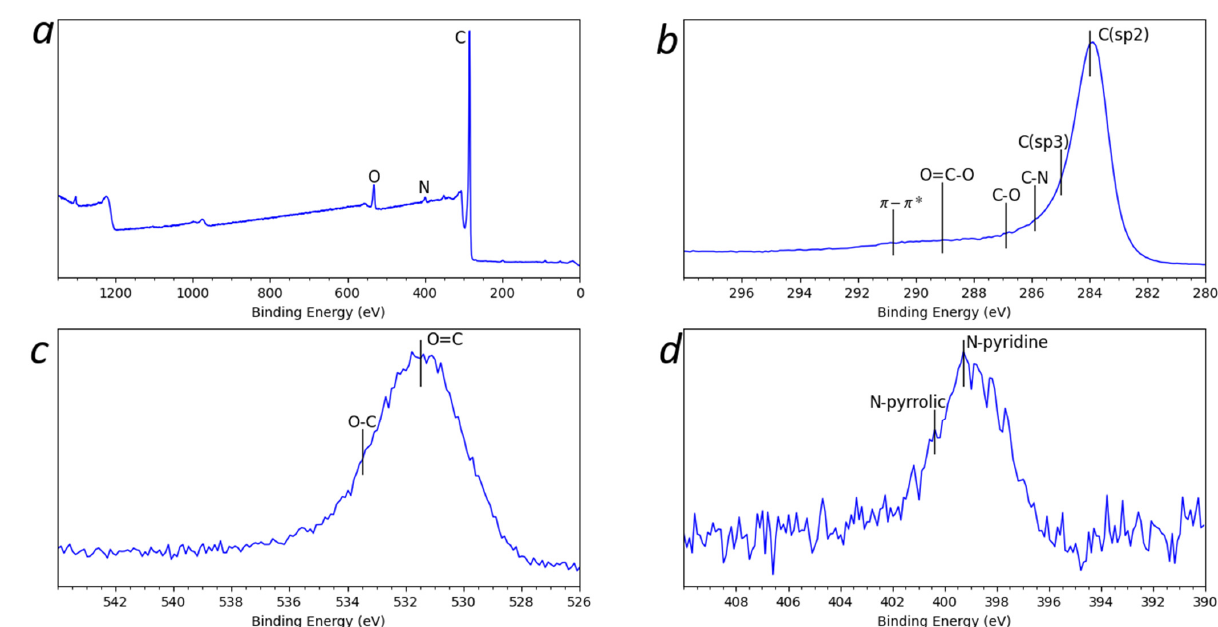
Figure 5. ( a ) XPS spectra analysis of ( b ) C1s, ( c ) O1s and ( d ) N1s for the synthesized multilayer graphene. layer graphene.